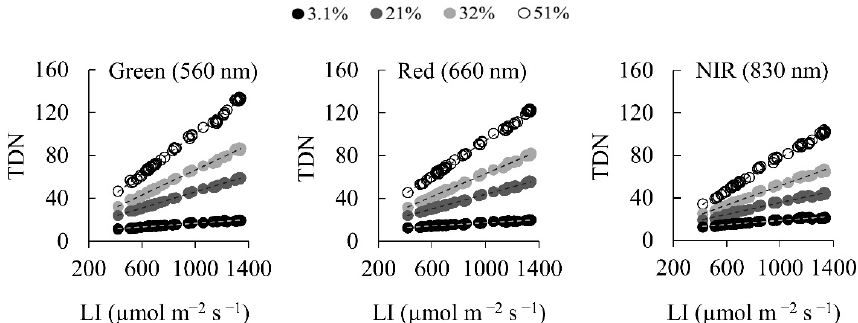
Figure 5. Relationships between the DN values of the four different reference tarps with reflectances of 3.1%, 21%, 32%, and 51% and light intensity (LI) at photosynthetically active radiation (400–700 nm). TDN: tarp digital number.